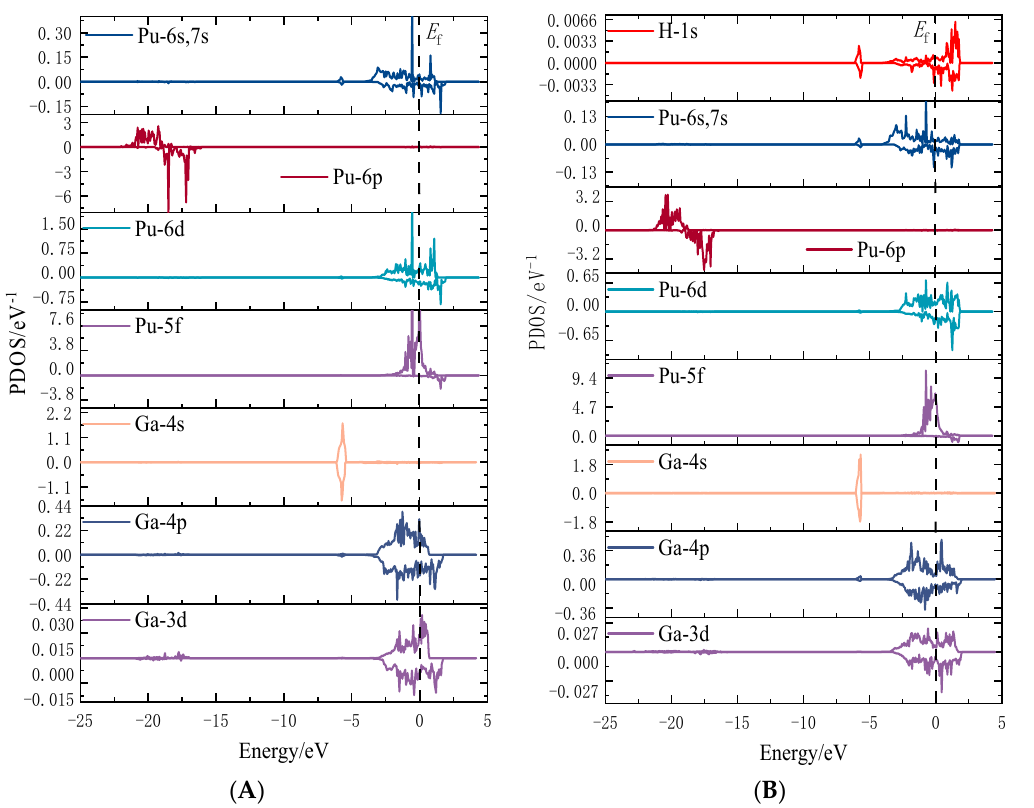
Figure 6. Fractional density of hydrogen gas molecules after adsorption on the surface of the plutonium–gallium system. ( A ) Fractional density of pure surface ( B ) Fractional density of hydrogen after adsorption.